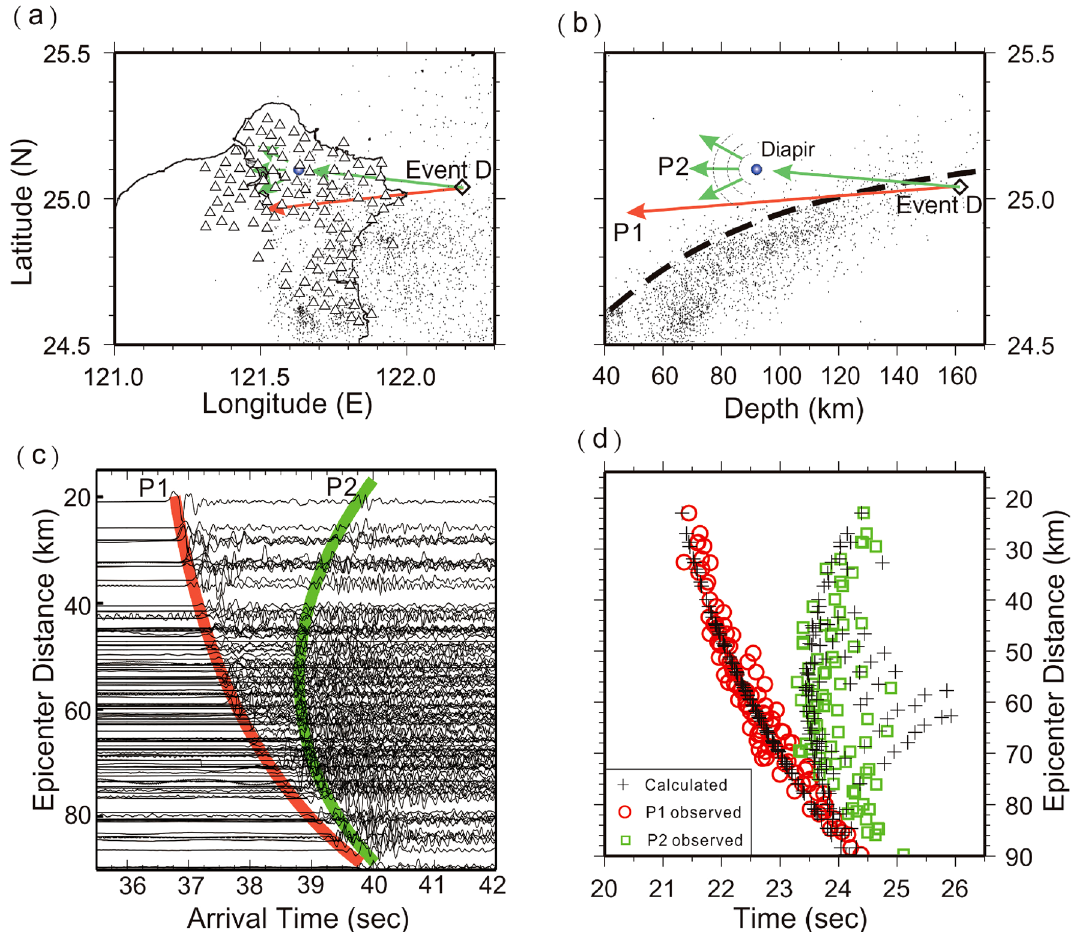
Figure 7. Locations of seismic stations (triangles), Event D (diamond) and diapir (blue circle) on the map ( a ) and depth profile ( b ). ( c ) The arrivals of P1 and P2 are, respectively, marked in red and green on the vertical seismograms plotted with epicentral distances. ( d ) The comparison between the observed arrivals of P1 (red circles) and P2 (green squares), and their calculated arrivals (pluses). This figure was partially created by Generic Mapping Tools (GMT version 4.5.2; URL: gmt.soest.hawaii.edu) and SAC software (version 101.5; URL: ds.iris.